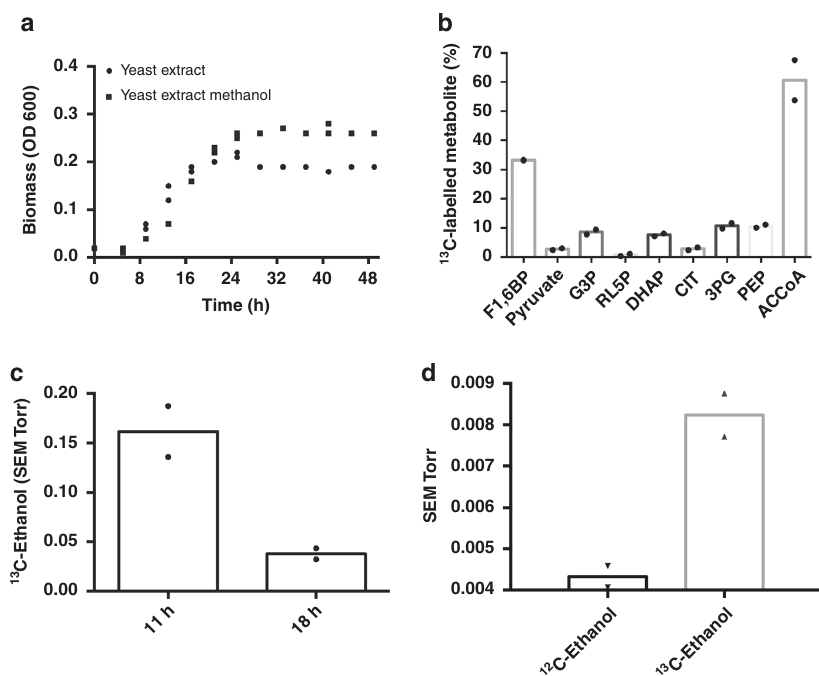
Fig. 1 13 C-methanol fermentations con fi rm methanol assimilation in S. cerevisiae . a Growth pro fi le of CEN.PK 113-5D (with empty vector pRS416) grown in liquid YNB medium with 0.1% yeast extract (circles) or with 0.1% yeast extract and 2% methanol (squares). Data points represent the measurement of two independent biological replicates. Source data are provided as a Source Data fi le. b Percentage of fully 13 C-labelled intracellular metabolite pool relative to total metabolite pool in CEN.PK 113-5D. F1,6BP fructose-1,6-bisphosphate, G3P glyceraldehyde-3-phosphate, RL5P ribulose-5-phosphate,